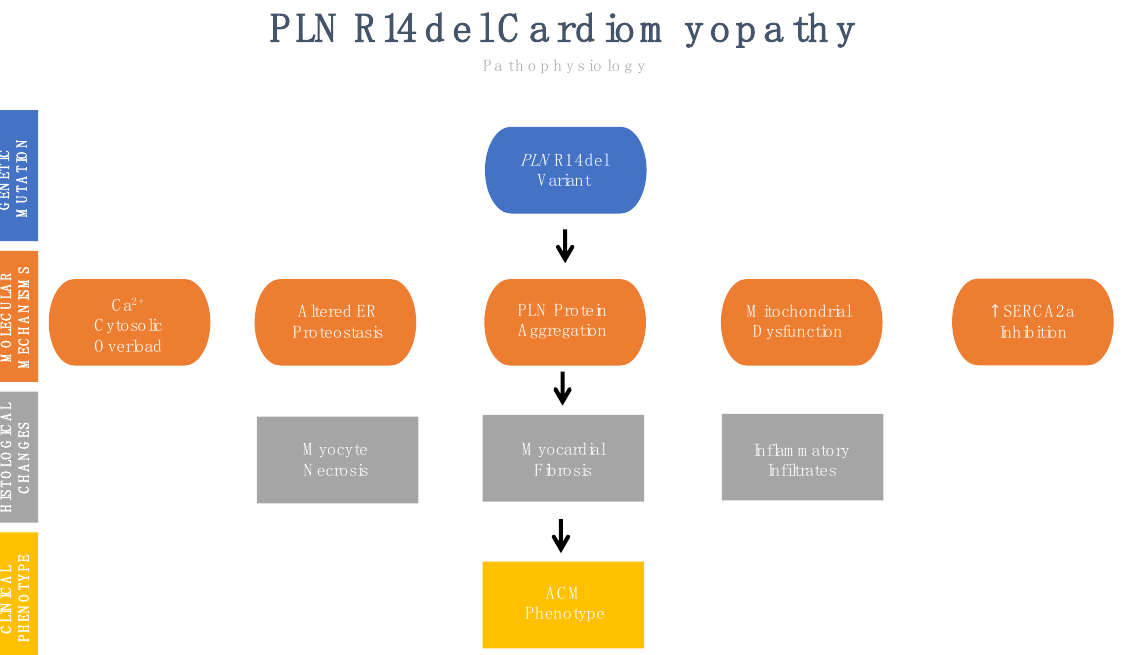
Figure 1. Pathophysiology of PLN R14del Cardiomyopathy. ACM, arrhythmogenic cardiomyopathy; ER, endoplasmic reticulum; PLN, phospholamban; SERCA2a, sarcoplasmic reticulum Ca2+